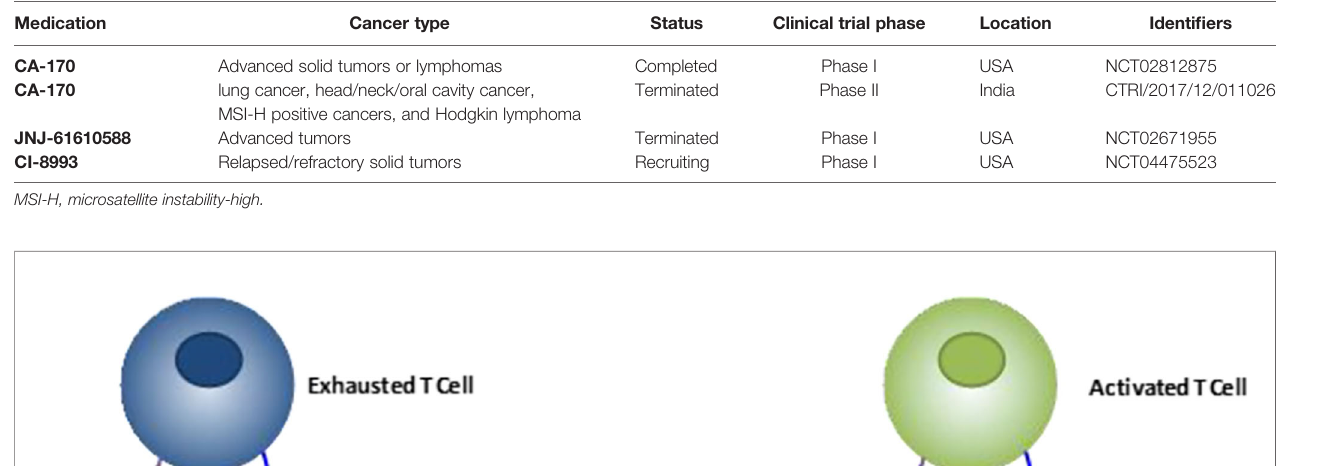
TABLE 1 | VISTA in clinical